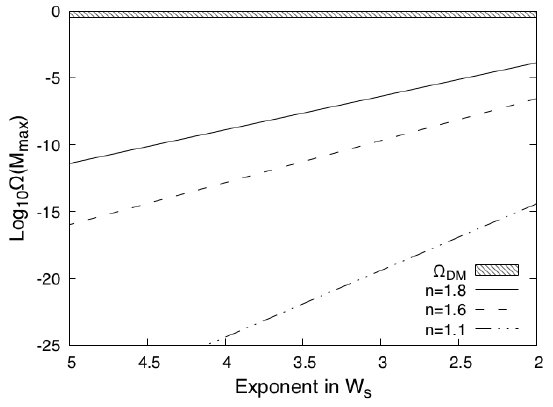
Figure 1 . We calculate the density parameter (cid:10) of the exponent in the probability for spherical collapse, (2.4), for di(cid:11)erent values of the spectral index n . The ceiling shown represents the current measured value for (cid:10) text, we allow for freedom in the exponent of the probability for spherical collapse W s (see (2.4)), which does make a signi(cid:12)cant di(cid:11)erence in the abundance, but even allowing for this freedom